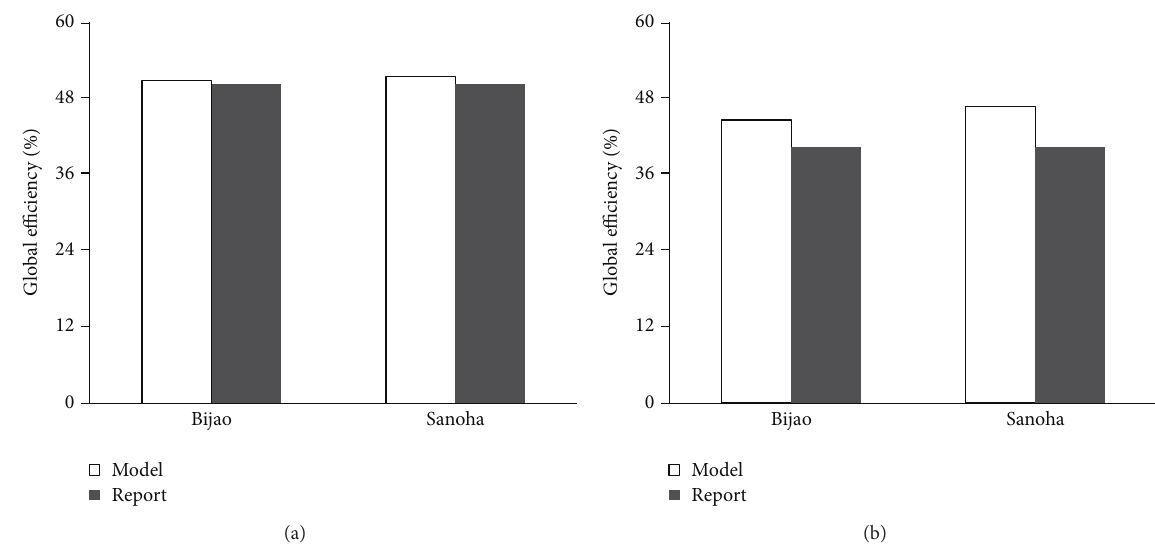
Figure 13: Global efficiency (%). Comparison between simulated and reported data for two Colombian coals; (a) slurry feeding technology and (b) dry feeding